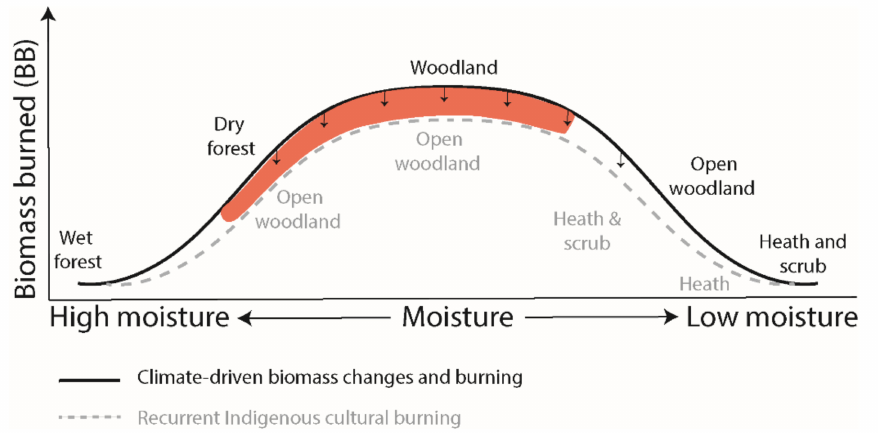
Figure 6. Proposed summary framework (adapted from McWethy et al., 2013) [20] of how climate (black solid line) and recurrent Indigenous cultural burning practices (grey dashed line) modulated fire regimes in southeast Australia during the Holocene. Recurrent Indigenous cultural burning is most important (shaded area) during dry phases in wet forests (drier fuel—dry forest) and during wet phases in woodlands (dense woodland), to reduce biomass accumulation and putting down- ward pressure on BB. Recurrent Indigenous cultural burning in dry forests and dense woodlands potentially promotes open woodland, with low biomass accumulation and burning. The likelihood of widespread burning in open woodland is low due to reduced fuel